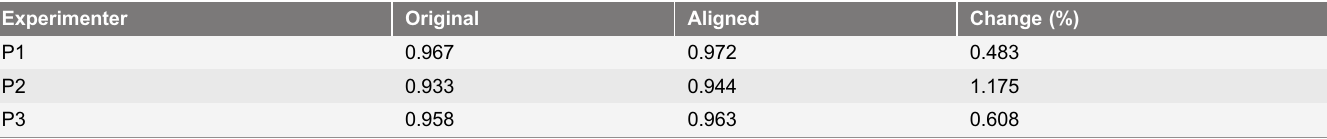
Table 2. The FindFoci algorithm closely matches human assignments a